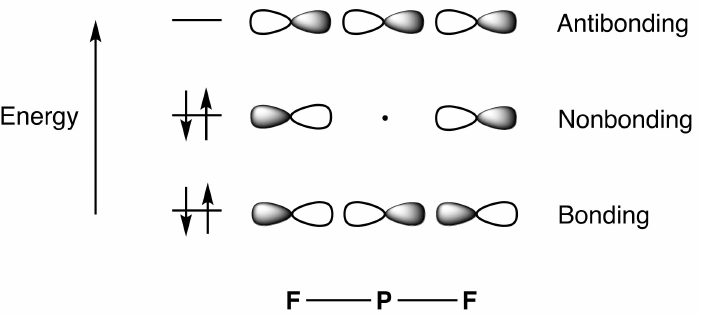
Figure 1. A simple MO energy-level diagram for the axial 3c,4e F–P–F unit in PF 5 . The orbitals on each of the fluorine atoms are shown as unhybridized p